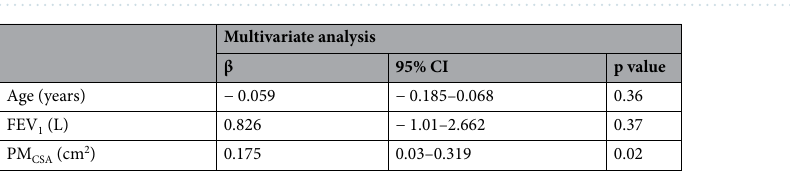
Table 5. Multivariate analysis of correlations between predictive variables. FEV 1 forced expiratory volume in 1 s, ECM CSA cross-sectional area of erector spinae muscles, β standardized β value, CI confidence interval.